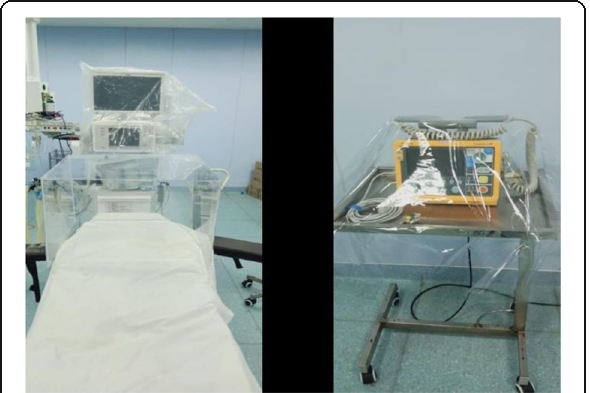
Fig. 1 Covering of equipment with plastic sheets Fig. 2 Anesthesia and surgical team in COVID